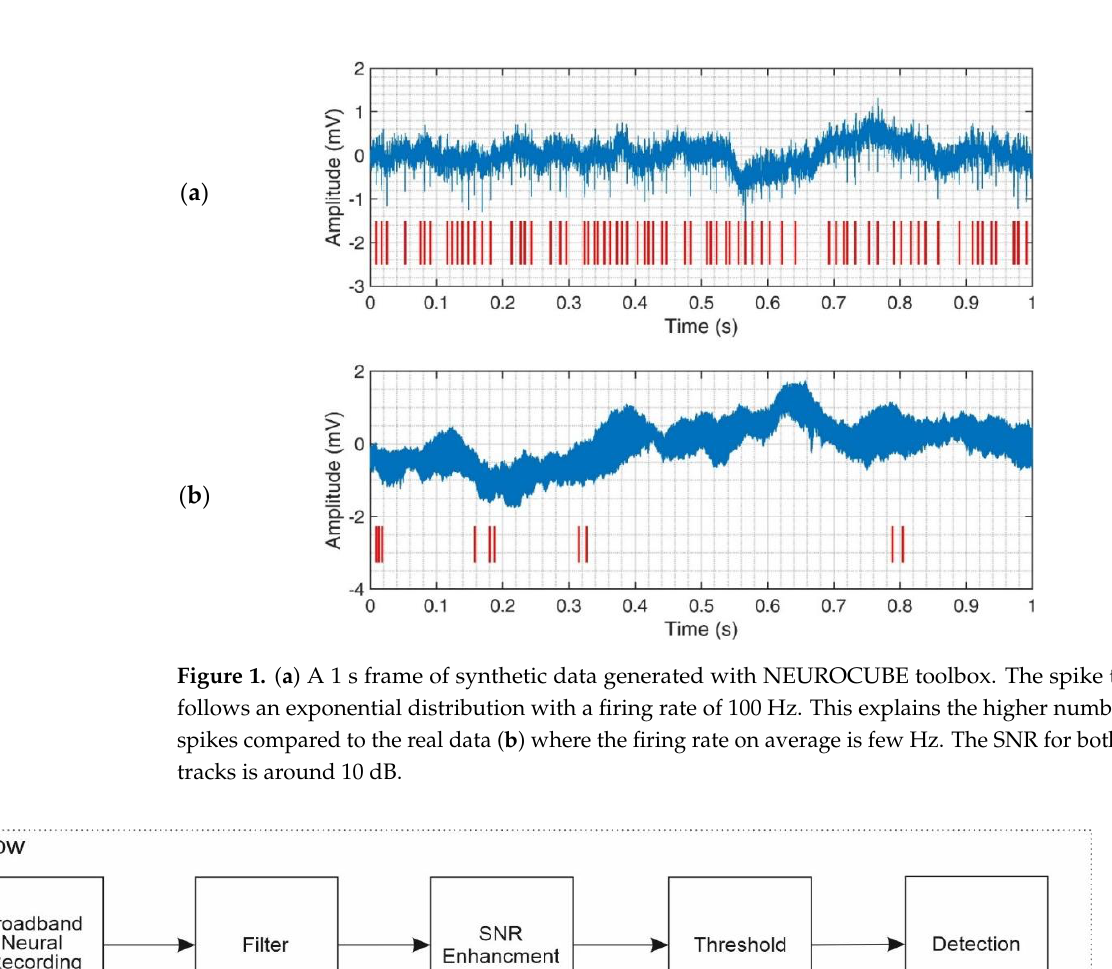
Figure 1. ( a ) A 1 s frame of synthetic data generated with NEUROCUBE toolbox. The spike train follows an exponential distribution with a firing rate of 100 Hz. This explains the higher number of spikes compared to the real data ( b ) where the firing rate on average is few Hz. The SNR for both the tracks is around 10 dB.